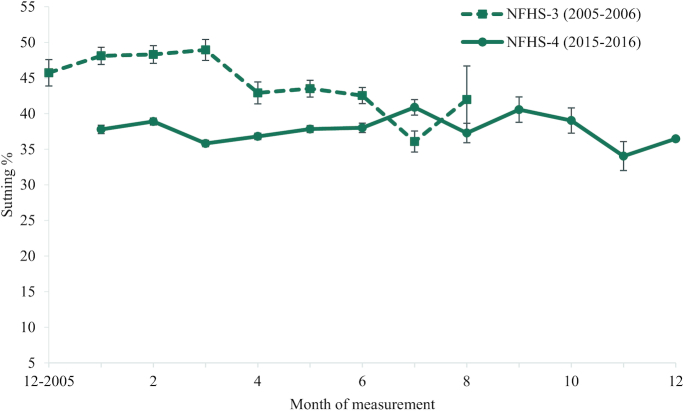
Weighted prevalence of stunting in India in NFHS-3 and NFHS-4 India by month of measurement. Data presented as mean estimate and 95% CI. NFHS, National Family Health Survey.